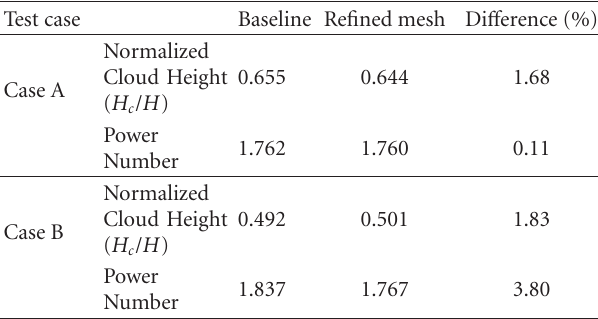
Table 1: Grid dependency study for the single-impeller tank.